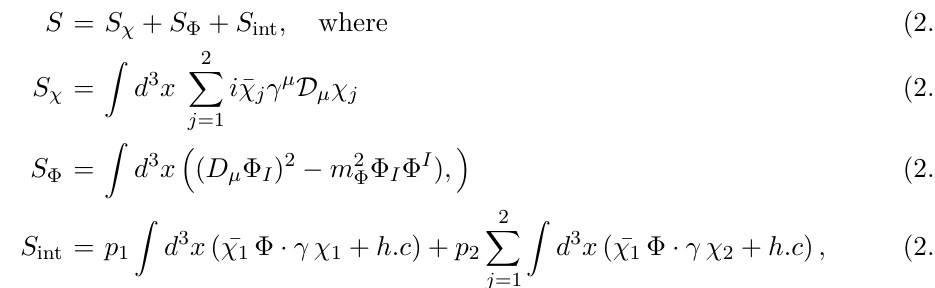
Figure 3. (a-c) Formation process of bent flat band by as we change the stregnth of the coupling. From the left to right B xyc = 0 , 5 , 10 . The chemical potential is fixed to be µ = 2 of flat band by hybridization of localized state and conducting